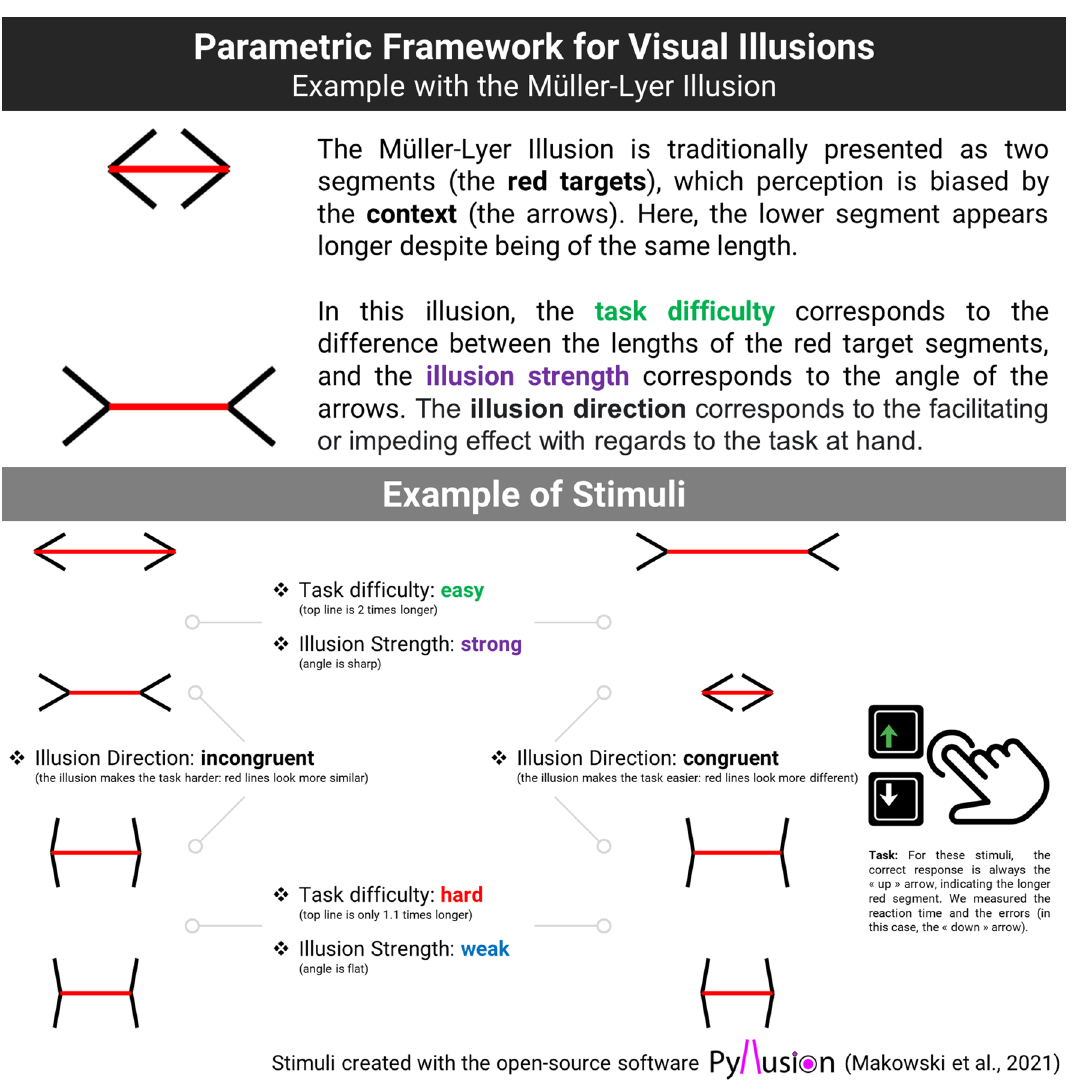
Figure 1. The parametric framework for visual illusions (Makowski et al., 2021) applied to the Müller-Lyer illusion (above). Below are examples of stimuli showcasing the manipulation of two parameters, task difficulty and illusion